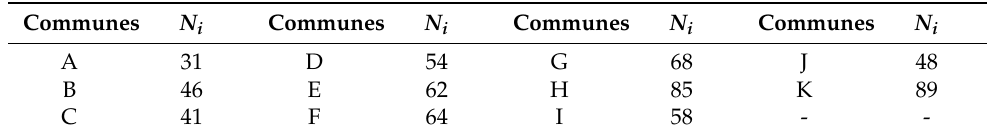
Table 1. The number of respondents in the